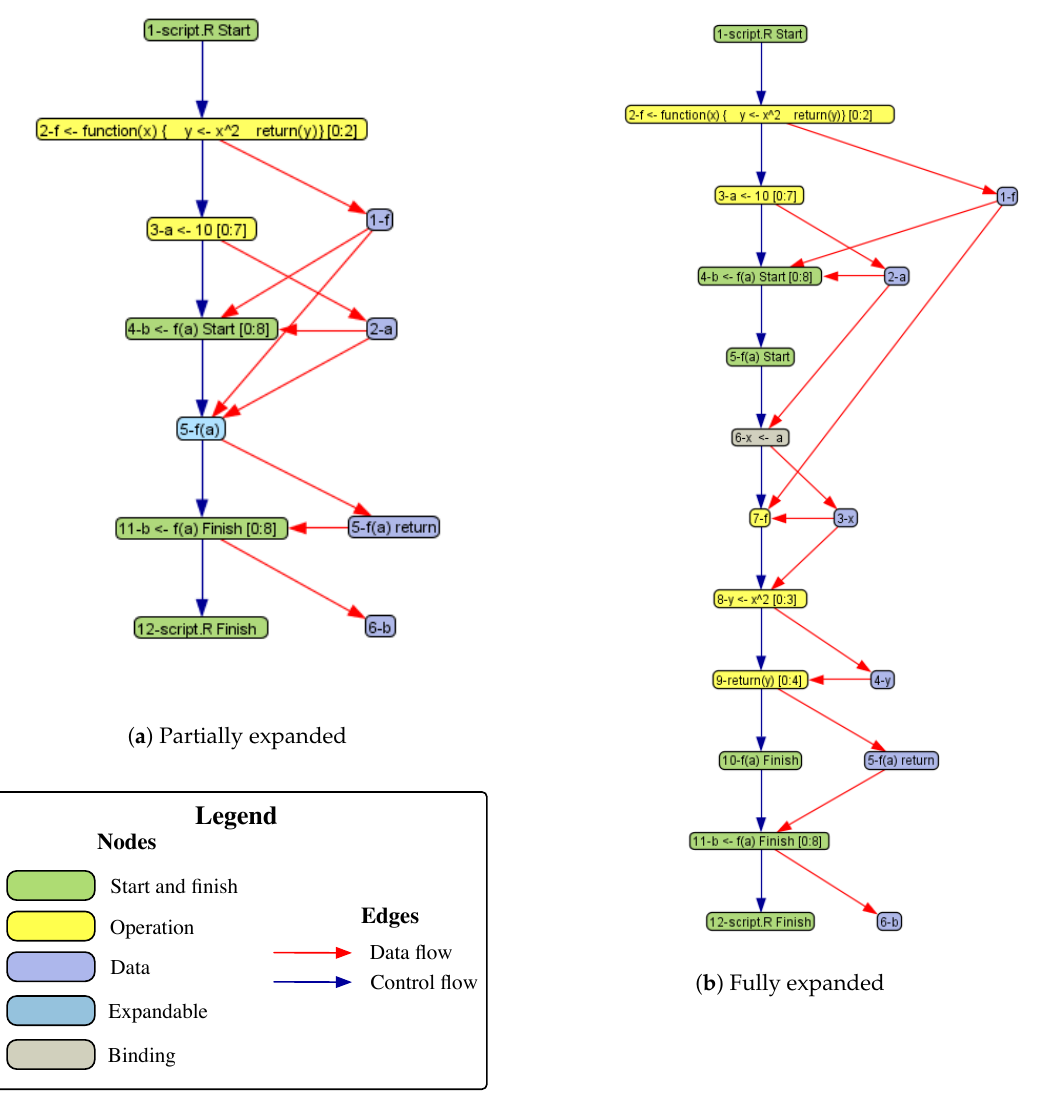
Figure 2. DDG with function